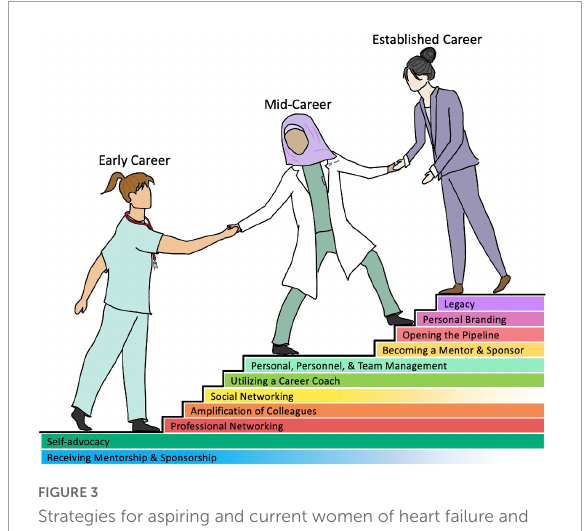
FIGURE3 Strategies for aspiring and current women of heart failure and CT surgery can utilize to persevere through gender-based